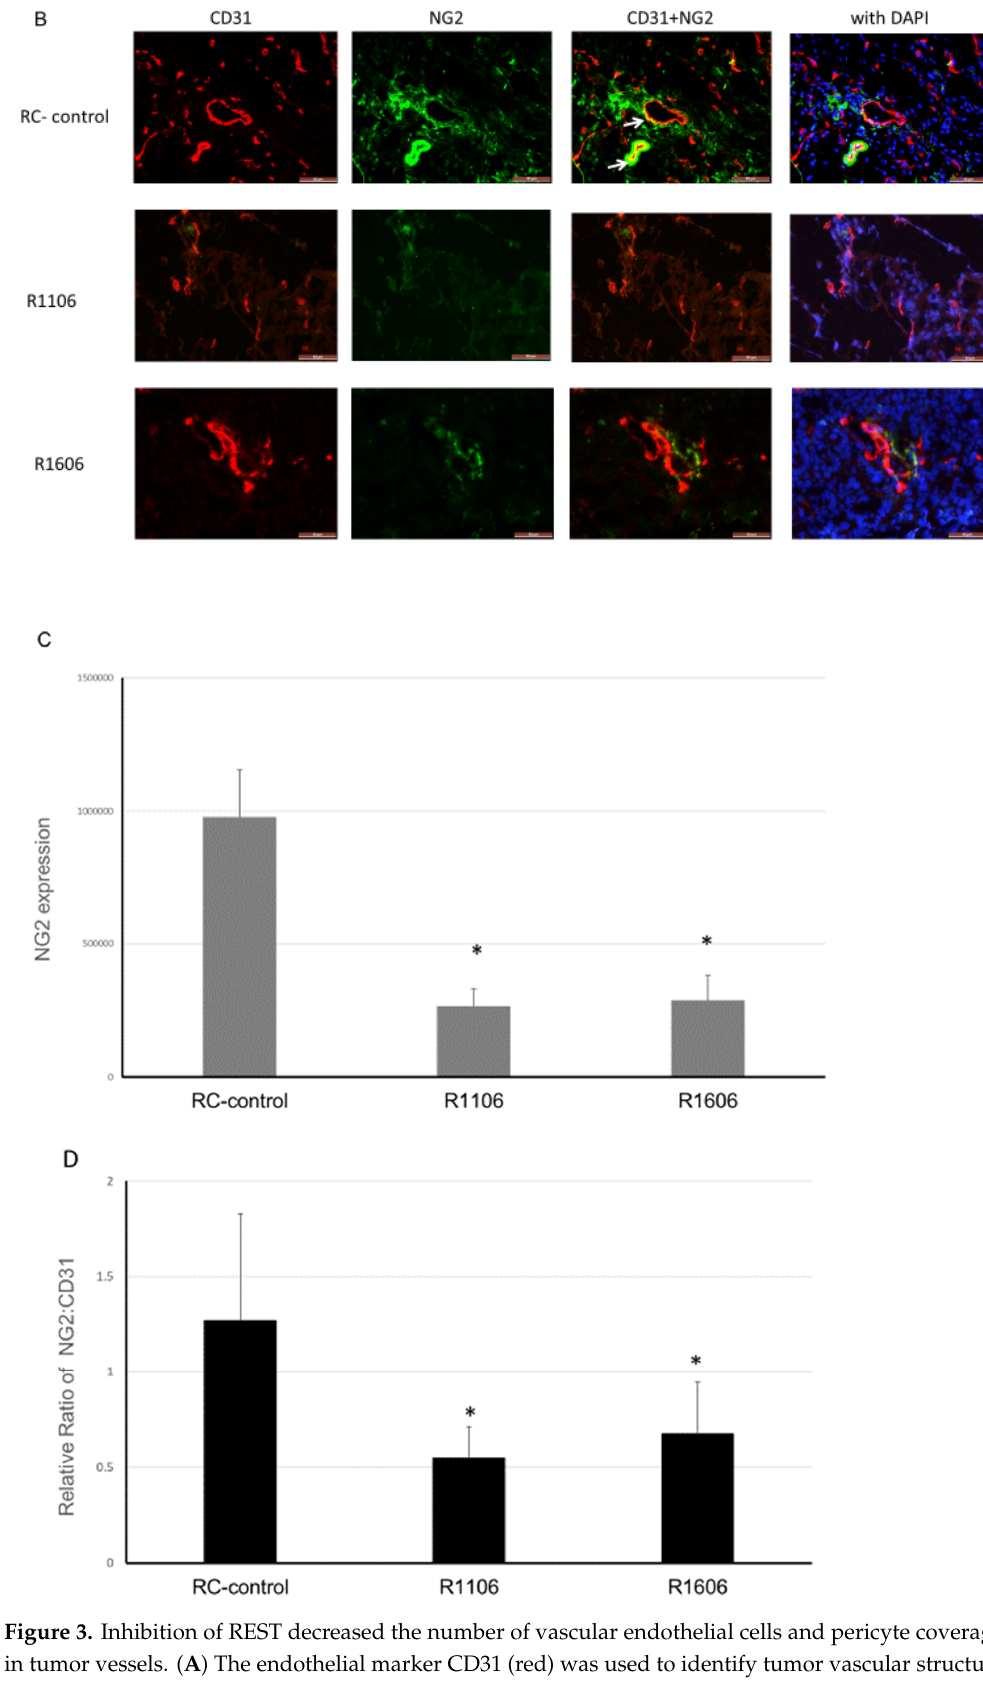
Figure 3. Inhibition of REST decreased the number of vascular endothelial cells and pericyte coverage in tumor vessels. ( A ) The endothelial marker CD31 (red) was used to identify tumor vascular